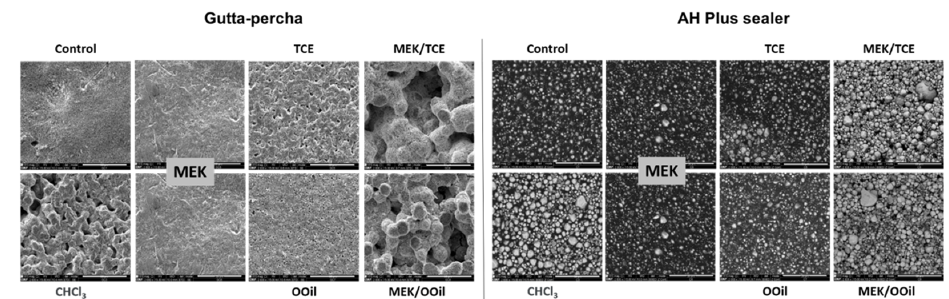
Figure 3. Representative scanning electron microscopy (SEM) images of the gutta-percha (secondary electron mode) and AH Plus (backscattered electron mode) samples before (control) and after 5 min of immersion in the tested solutions—CHCl 3 , chloroform; MEK, methyl ethyl ketone; TCE, tetrachloroethylene; OOil, orange oil. Mixtures: MEK/TCE; MEK/OOil. Bar = 50 µm.